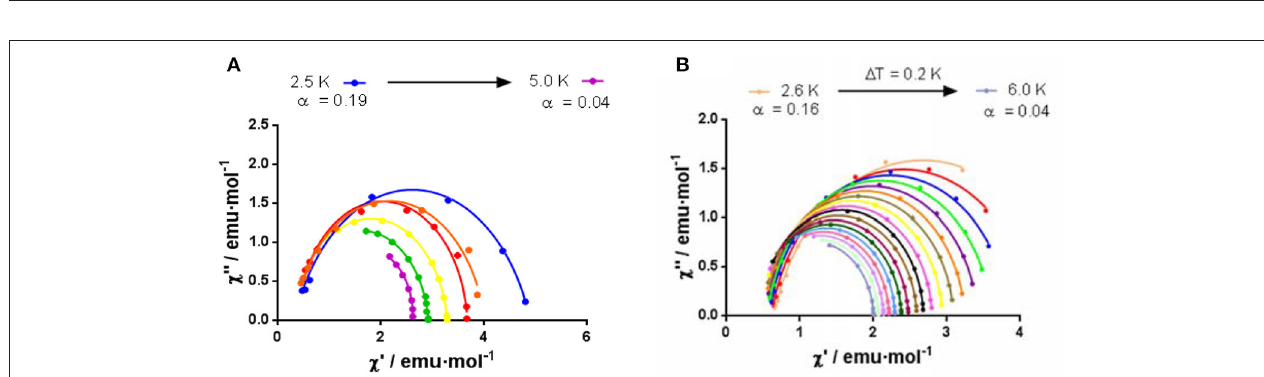
FIGURE 10 | Cole–Cole plot in 1000 Oe dc field for 2 (A) and 8 (B) .